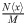
(Color online) Population average of x for various systems with threshold dynamics, for M = 2, dt = 0.01, L = 300.Note that in a-c, the value plotted is N〈x〉M, such that a value of 1 means that on average, exactly M players are cooperating in each match. Example behaviour of mean field, full mixing and random networks, N = 7. a)Example behaviour of rings without long connections. The outlier is N = 3. b) Example behaviour of rings with few long connections. c) Comparisons of critical α-values for different models, as a function of N. “Fully Mixed” and “Random Topology” overlap for part of the range.